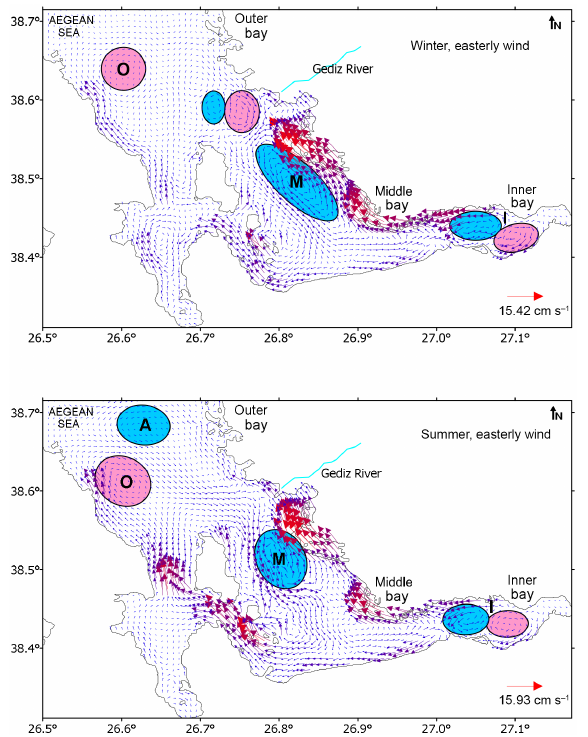
Figure 6. The barotropic current pattern (depth averaged) in the case of an easterly winder in winter and in summer.